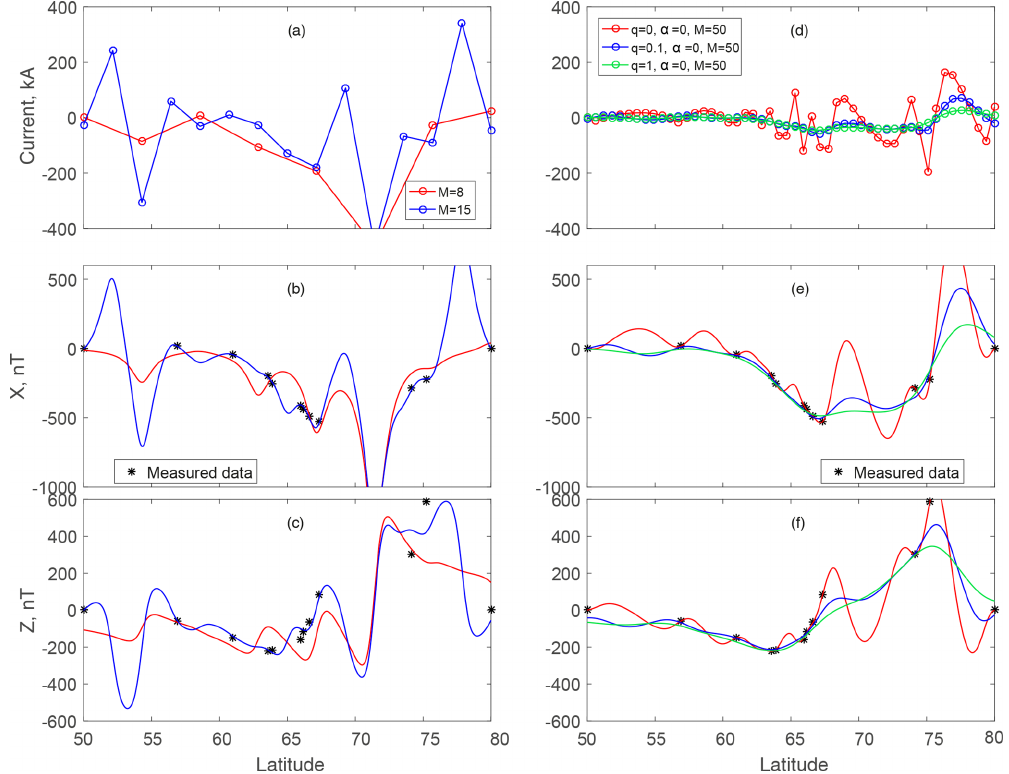
Figure 4. Event on 24 November 1996 at 23:09:00UT. (a, b, c) Model 1 with 8 and 15 wires with no regularization. (d, e, f) Model 1 with 50 wires with and without regularization. The measured field is shown using black stars, and the model field and current are shown using